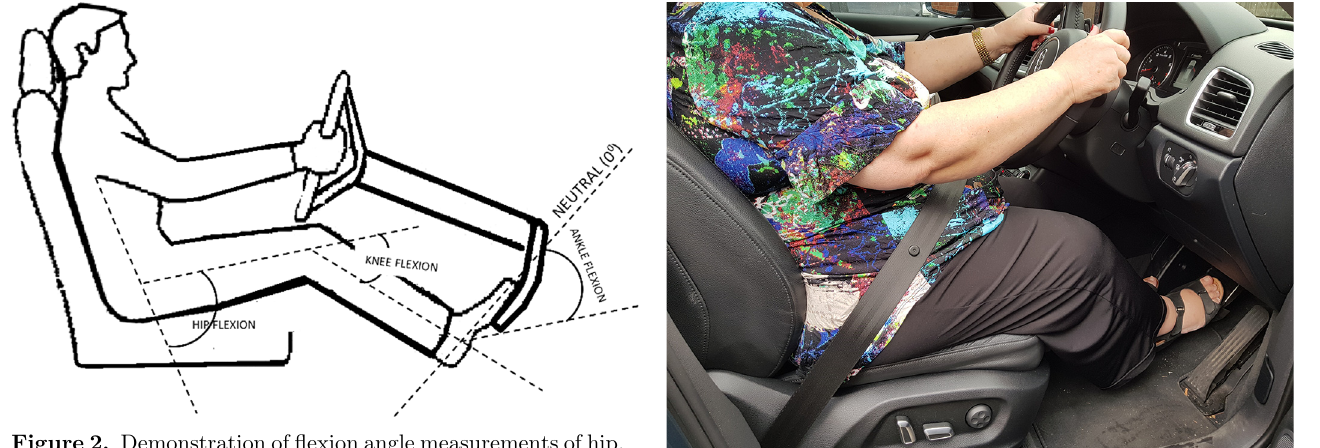
Figure 2. Demonstration of fl exion angle measurements of hip, knee and ankle joints.